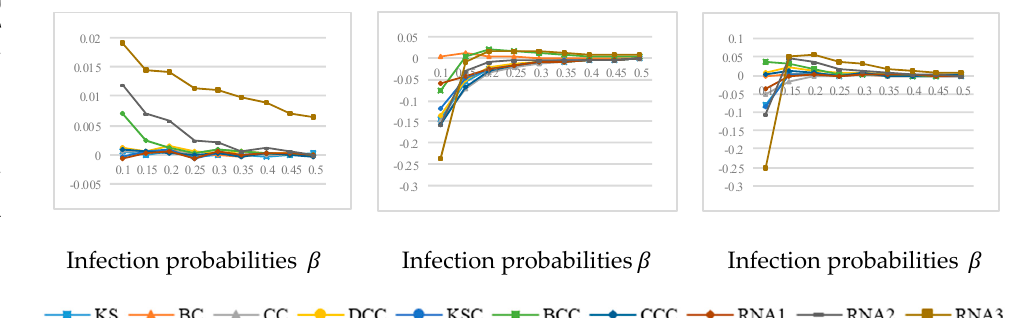
Figure 5. In full-contact SIR model, the relationship between Δ and β . with 1% nodes in key node set.